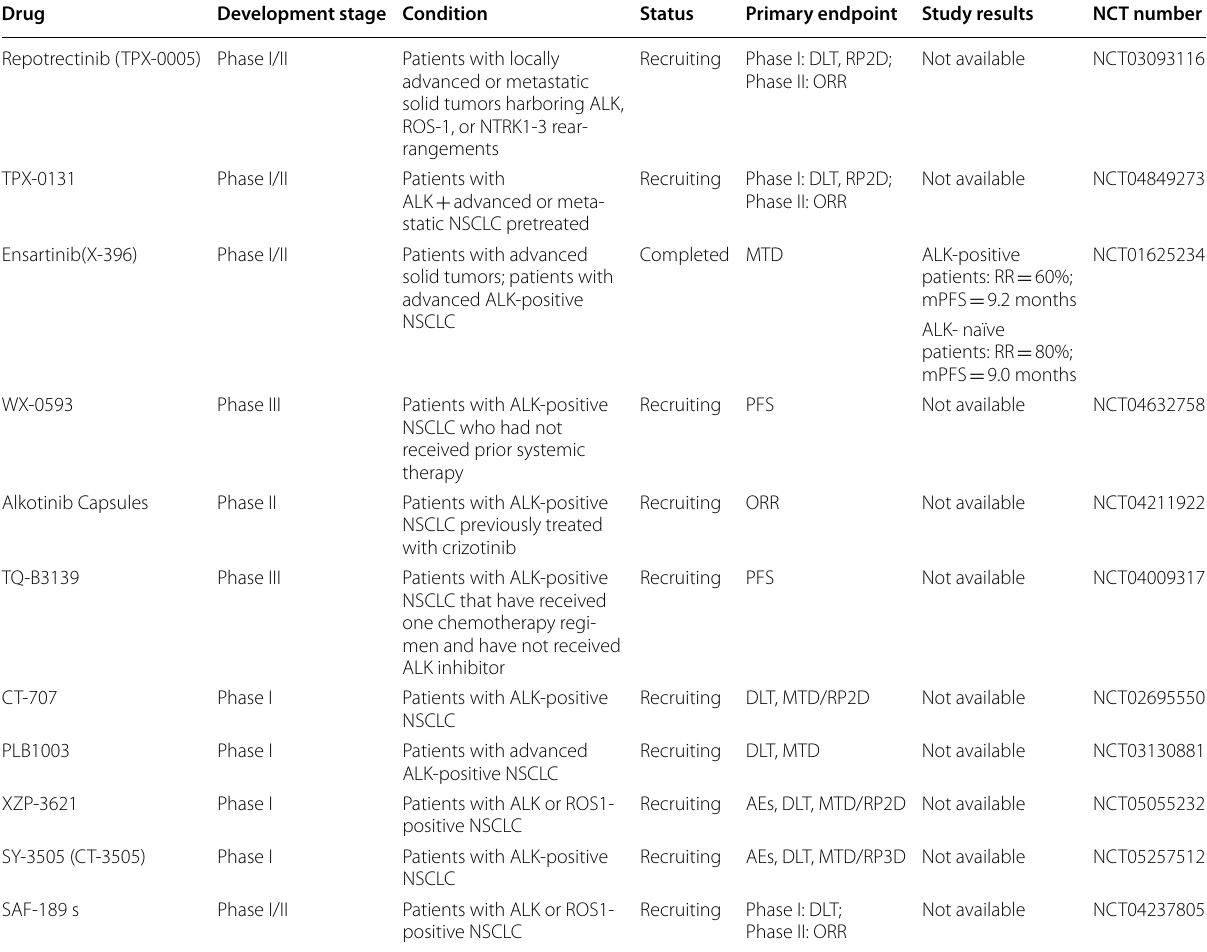
Table 2 Current novel ALK TKIs in clinical trials